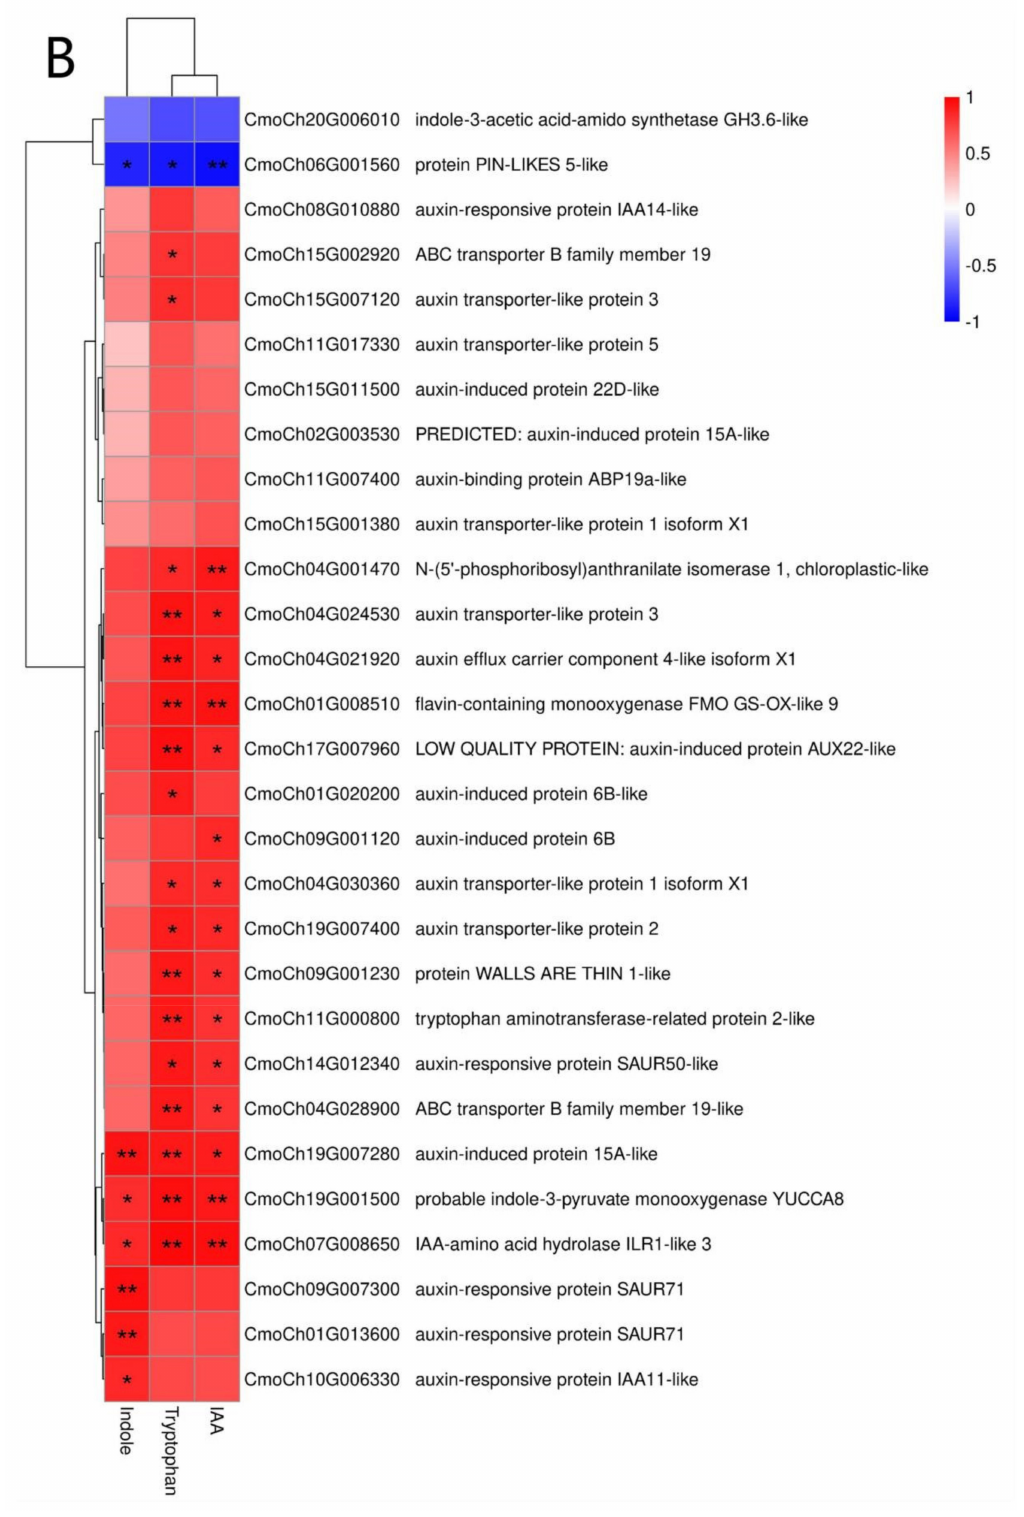
Figure 3. ( A ) Expression heatmap of DEGs related to auxin response in pumpkin during EOD-FR treatment. ( B ) Heatmap of correlations between auxin-related DEGs and differentially accumulated auxin metabolites. * Correlation ≥ 0.8. ** Corre- lation ≥